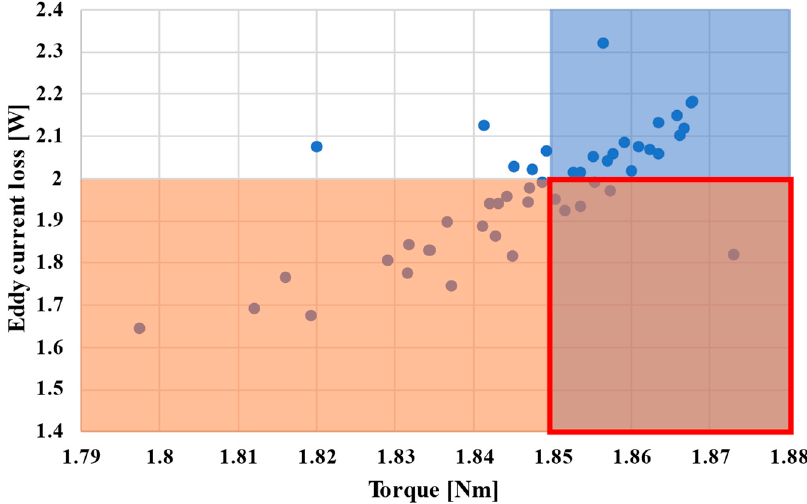
Figure 7. Satisfied eddy current loss and torque graph.